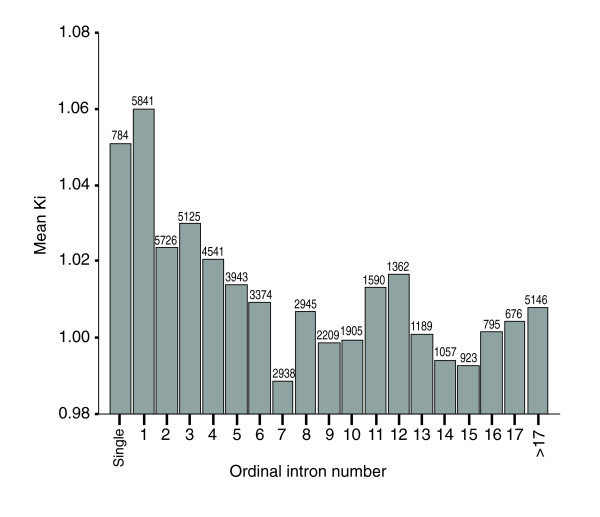
Mean Ki as a function of the ordinal position of introns (relative to other introns of the same gene). Single introns constitute a special category. All introns whose number within the gene was above 20 were pooled together, to avoid classes of sample size that was too different. The number above each bar represents the sample size of each category. First and single introns are the more divergent ones.